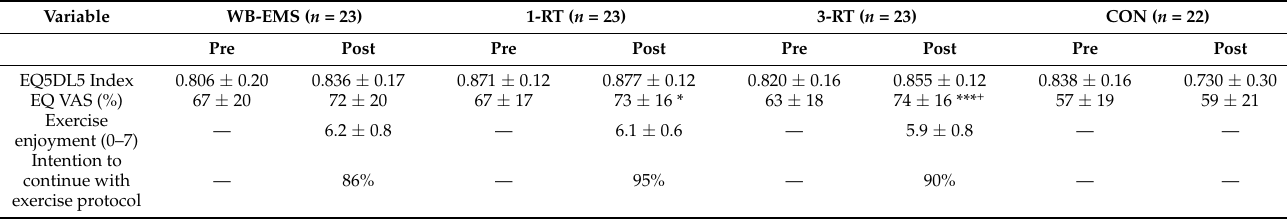
Table 7. Self-reported outcomes pre and